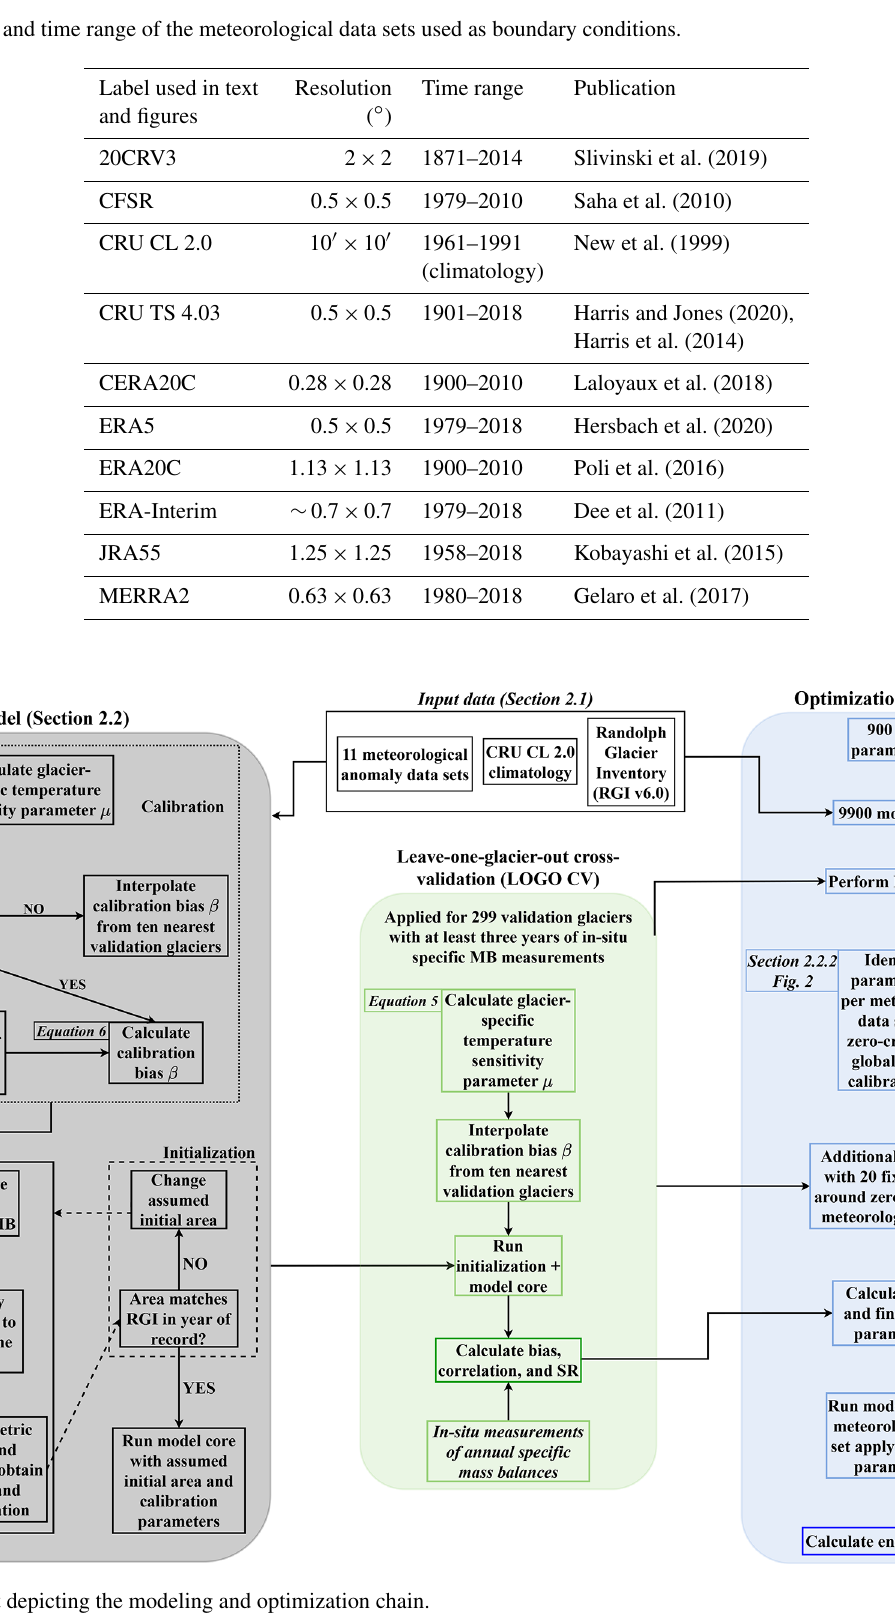
Figure 1. Flowchart depicting the modeling and optimization